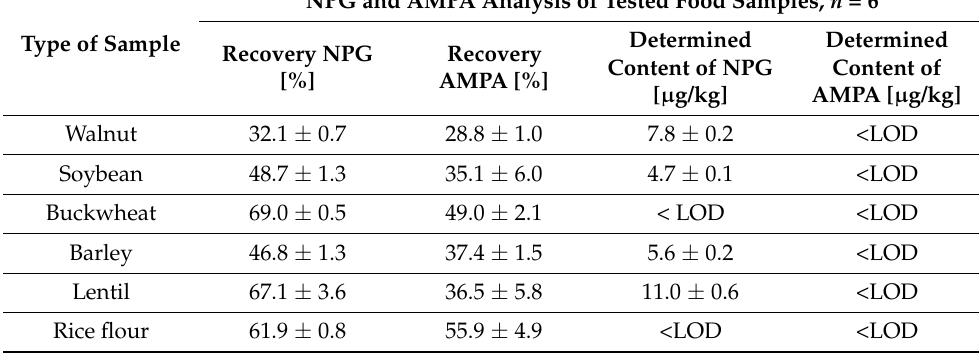
Table 5. Determined values of NPG and AMPA concentration in the tested samples.